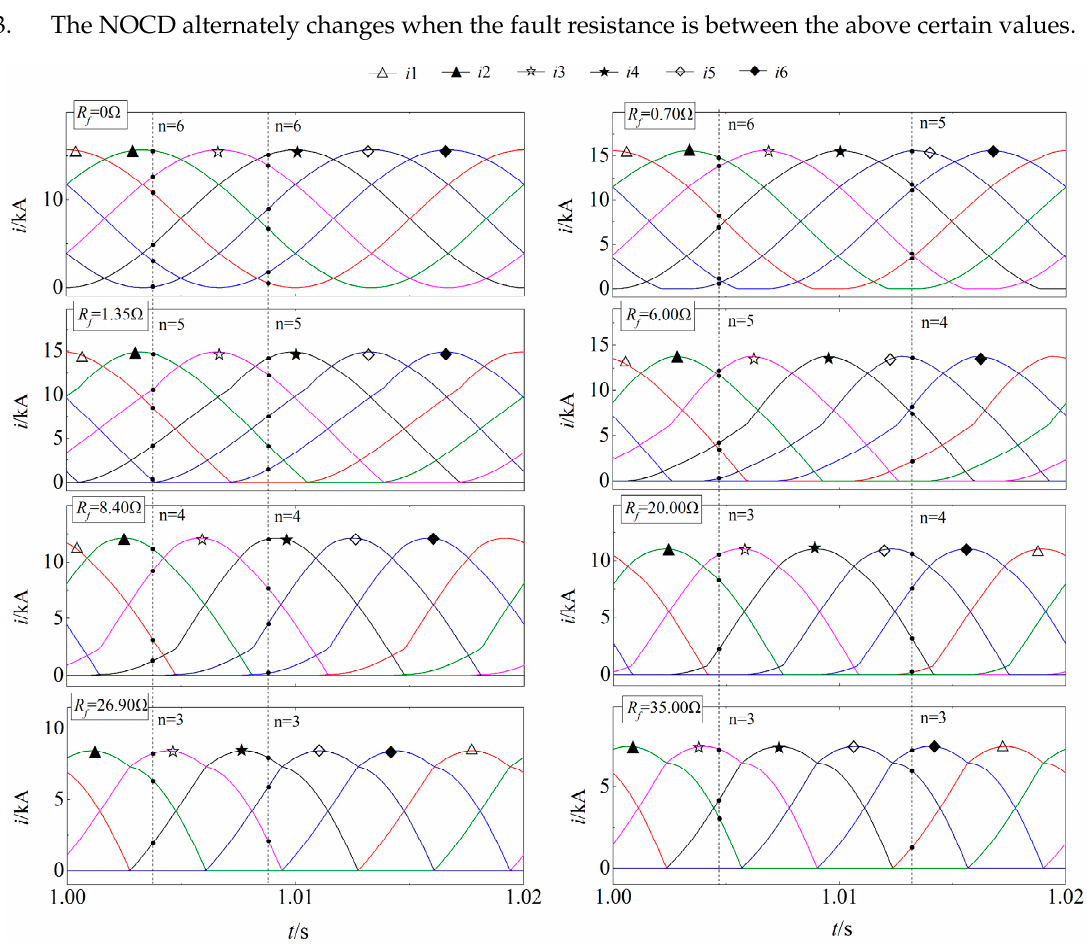
Figure 5. Arm current under pole ‐ to ‐ pole faults with variant fault resistance.